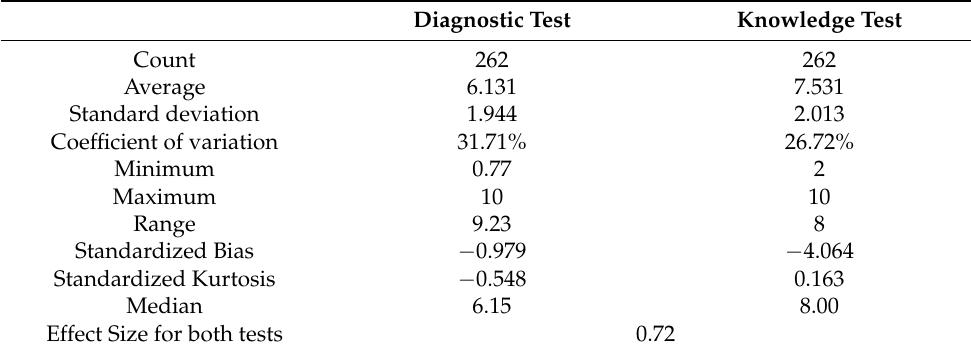
Table 7. Summary statistics for Diagnostic and Knowledge